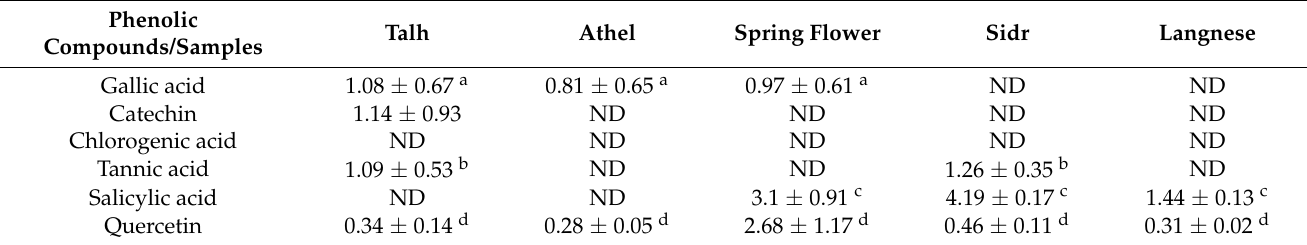
Table 2. Phenolic compounds (mg/100 g) in honey samples analyzed by